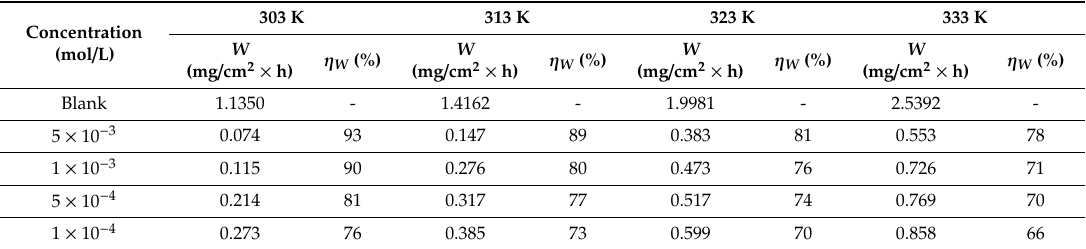
Table 2. The temperature e ff ect toward inhibition e ffi ciency and corrosion rate of 3-BIT. 303 Concentration (mol / L)